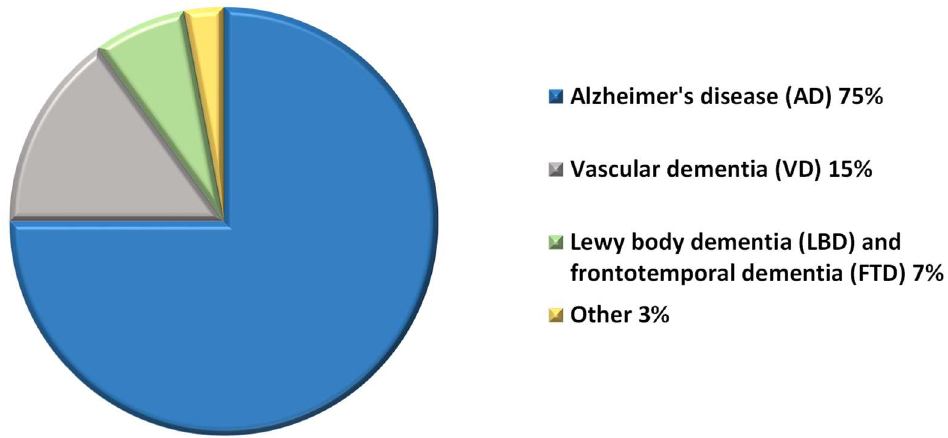
Figure 1. Graphical representation of types of dementia.